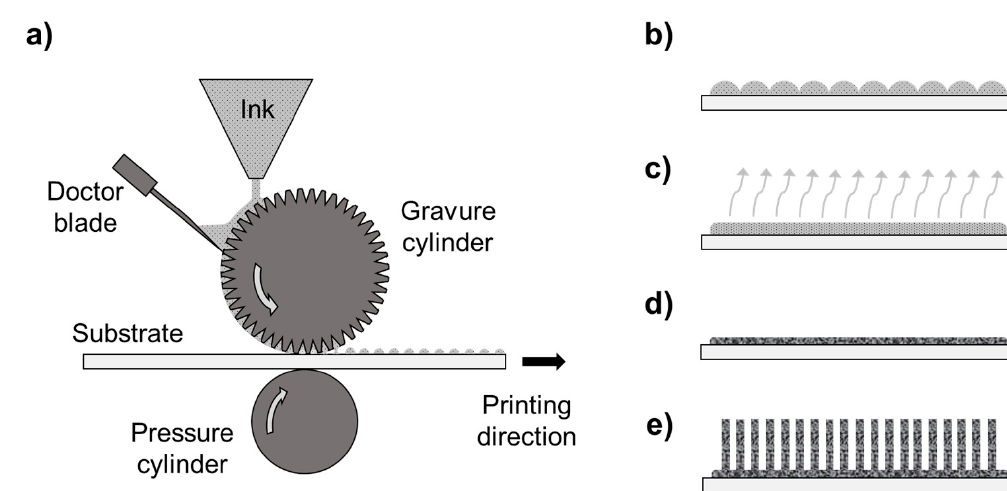
Figure 1. Fabrication process of ZnO seed layers by gravure printing and subsequent NW growth. The gravure printing process can be divided in the following steps: ( a ) inking, doctoring, and transfer; ( b ) spreading; ( c ) drying; ( d ) production of the final solid thin film. ( e ) The final growth of ZnO NWs is performed via low-temperature CBD.